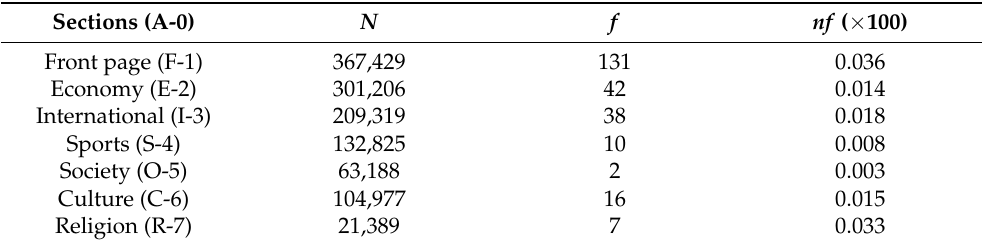
Table 5. Raw vs. normalized frequencies of the central word in multiple newspaper sections for the year